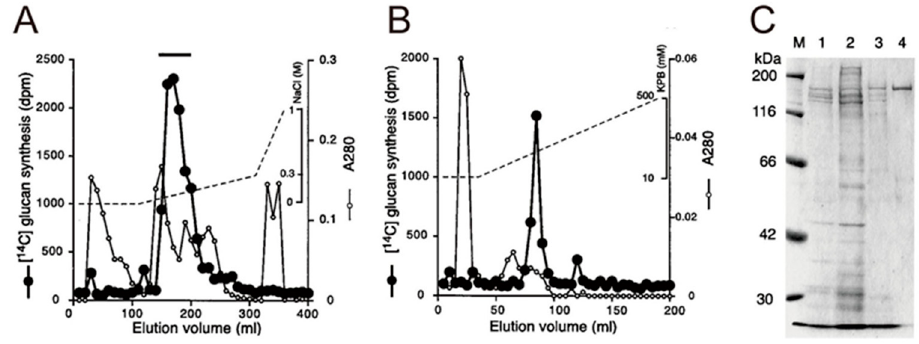
Figure 8. Purification of GTFR from Streptococcus oralis ( S. oralis ) ATCC 10557 by sequential chromatography on a Q Sepharose FF column (eluted with a linear gradient of 0 to 0.3 M NaCl) ( A ) and Bio-Scale CHT10-I column ( B ). Elution was done with a 10 to 500 mM KPB linear gradient. ( C ) SDS-PAGE of GTase preparations at different stages of purification. Lanes: 1, culture supernatant; 2, ammonium sulfate precipitate; 3, pooled active fractions from Q-ion-exchange chromatography; 4, pooled active fraction from CHT-10 hydroxylapatite chromatography; M, molecular mass markers. Cited from Reference [53] with permission.